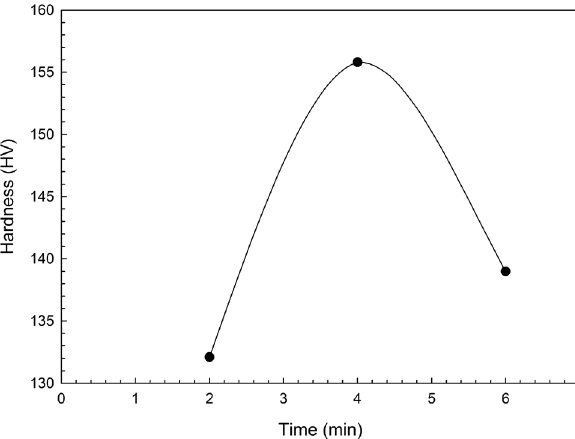
Fig. 9: Hardness values of the composites manufactured at 800 °C temperature and 500 rev/min stirring speed, with 6% reinforcement volume in 2, 4 and 6 minutes